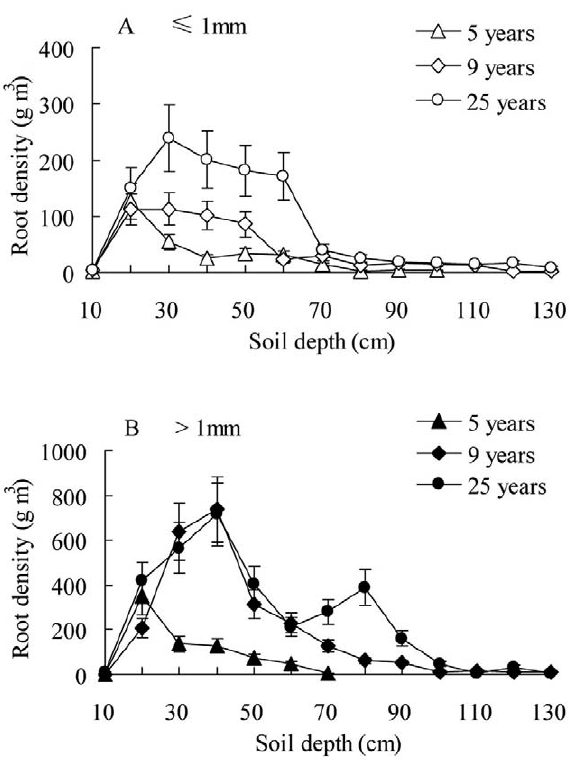
Figure 4. Root density of different ages of Caraganaintermedia plantations. Three replicates of soil profile (50 cm 6 50 cm) was dug in each age of C. intermedia plantation.